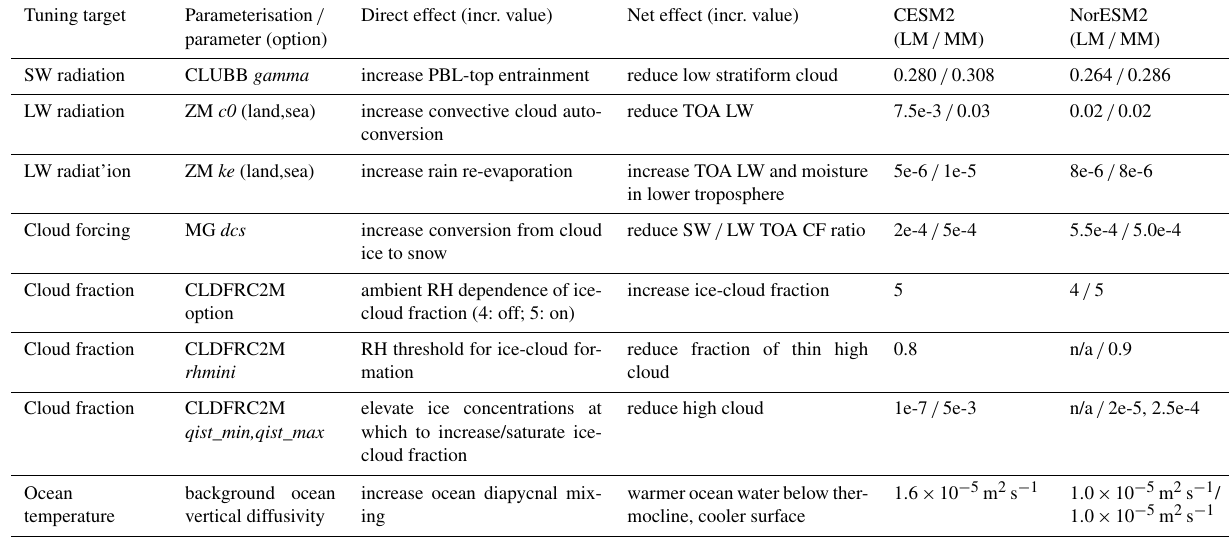
Table 2. Tuning parameters of NorESM2-LM and NorESM2-MM. Compared to CESM2 (Danabasoglu et al., 2020) where applicable. Tuning